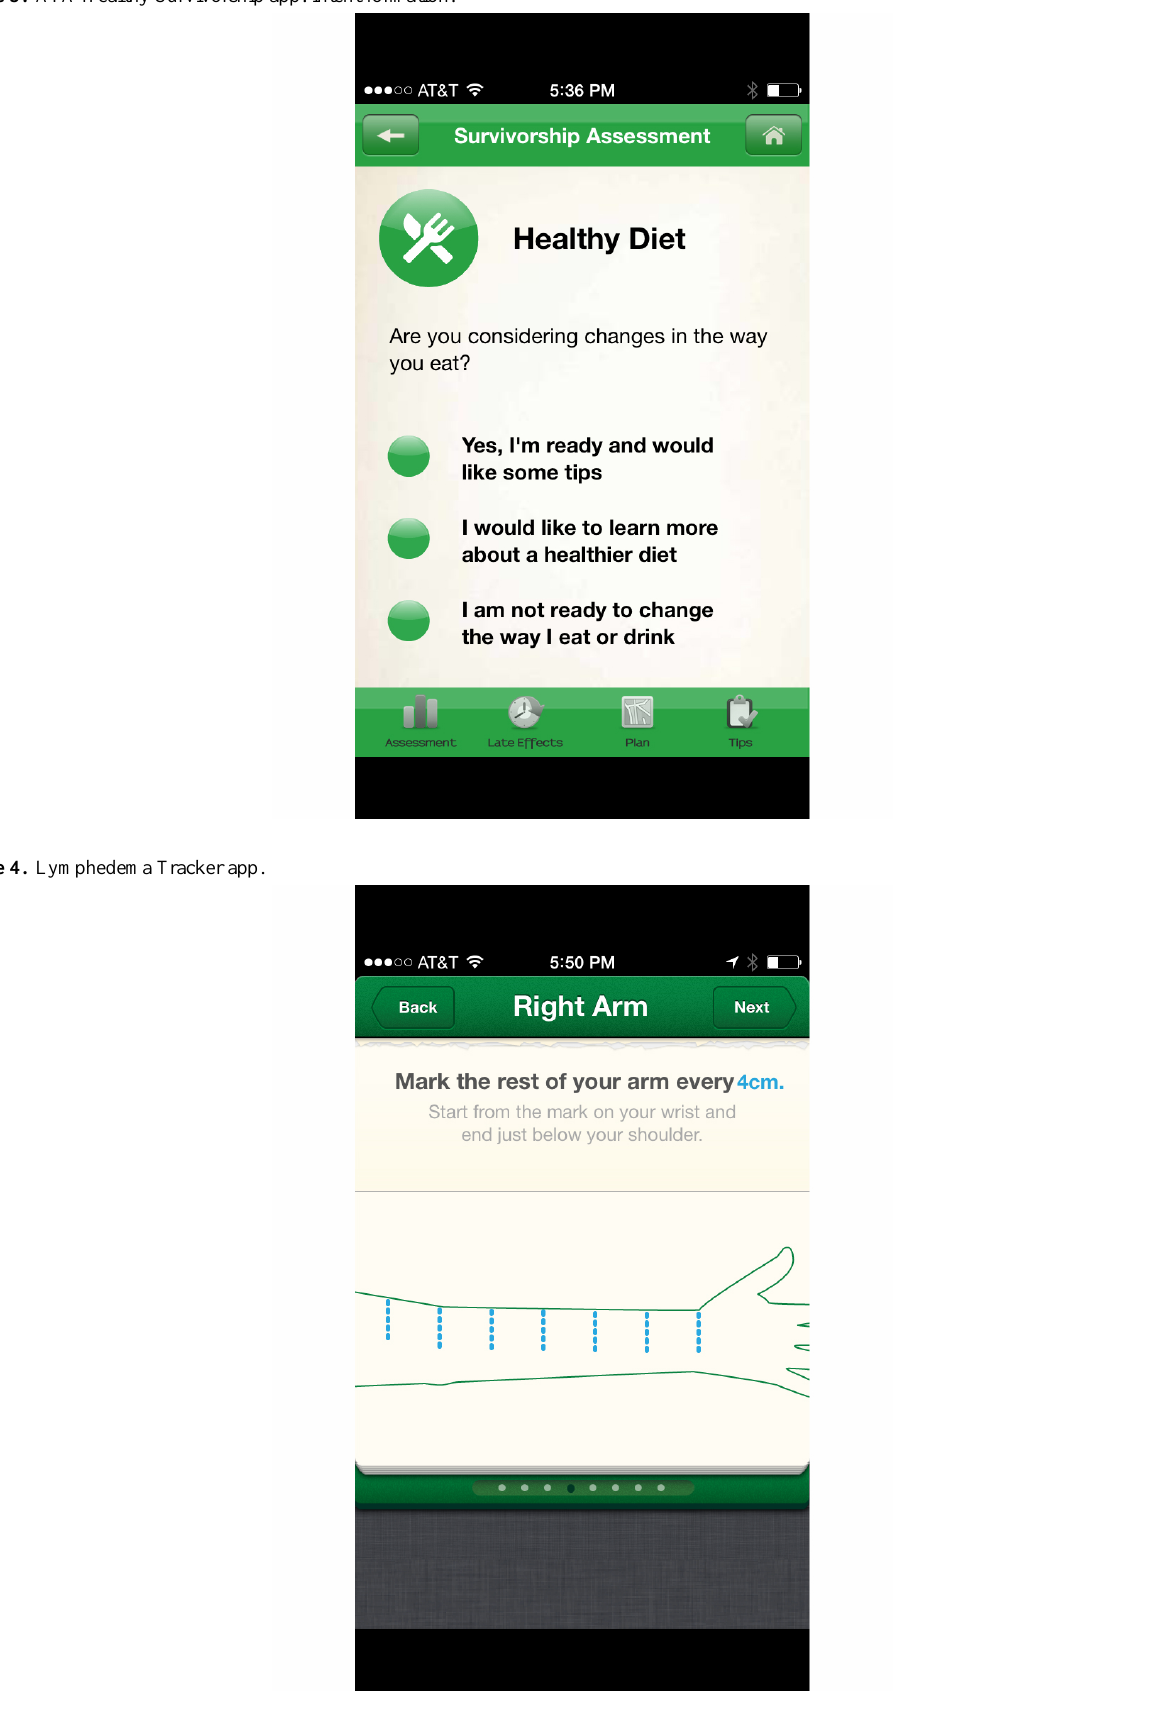
Figure 3. AYA Healthy Survivorship app: intent formation.